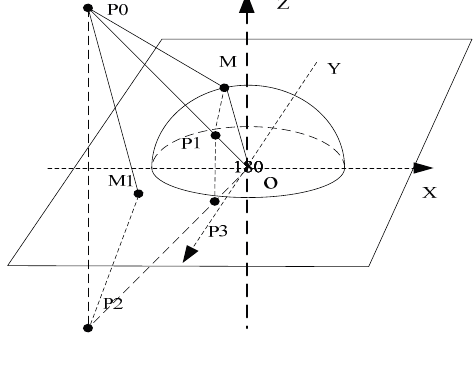
Figure 2. The electric field distribution of the hemisphere